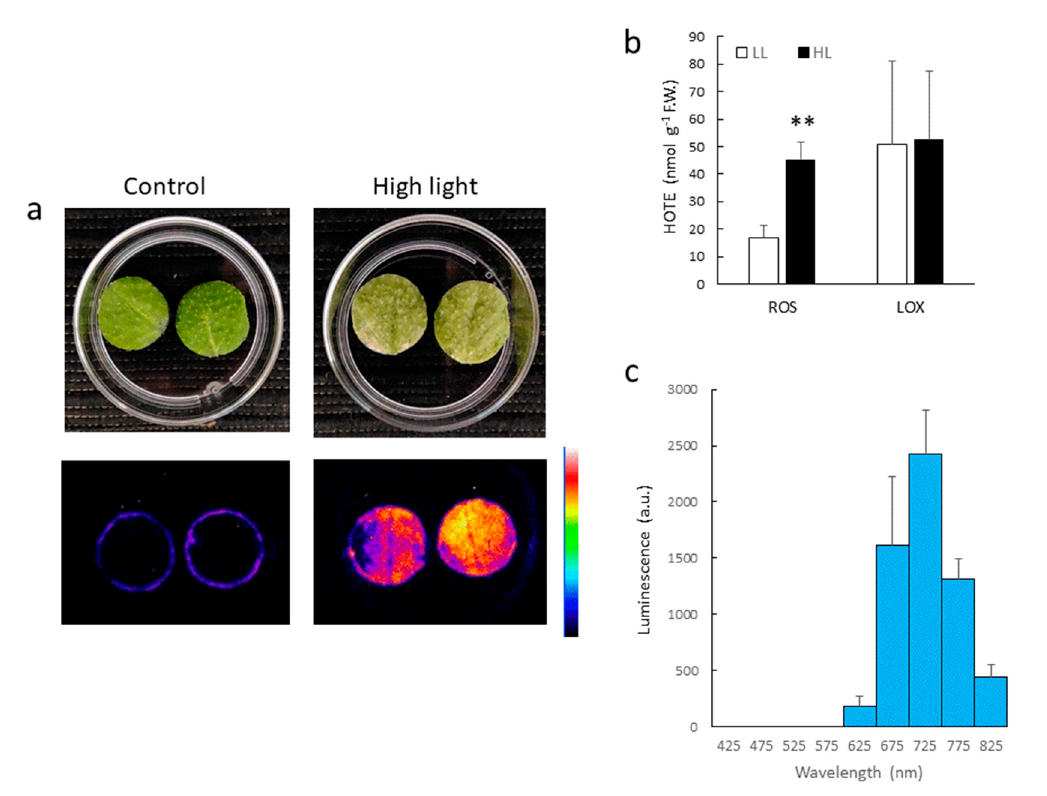
Figure 2. SCL emission induced by a high light treatment of WT Arabidopsis leaf discs. ( a ) Picture and SCL image of control and high light-treated leaf discs. ( b ) ROS- and LOX-mediated HOTE accumulation. **, significantly different from LL at p < 0.005 (Student’s t -test). ( c ) SCL spectrum of high light-treated leaf discs. Leaf discs were exposed to white light of PFD 1400 µmol m − 2 s − 1 .